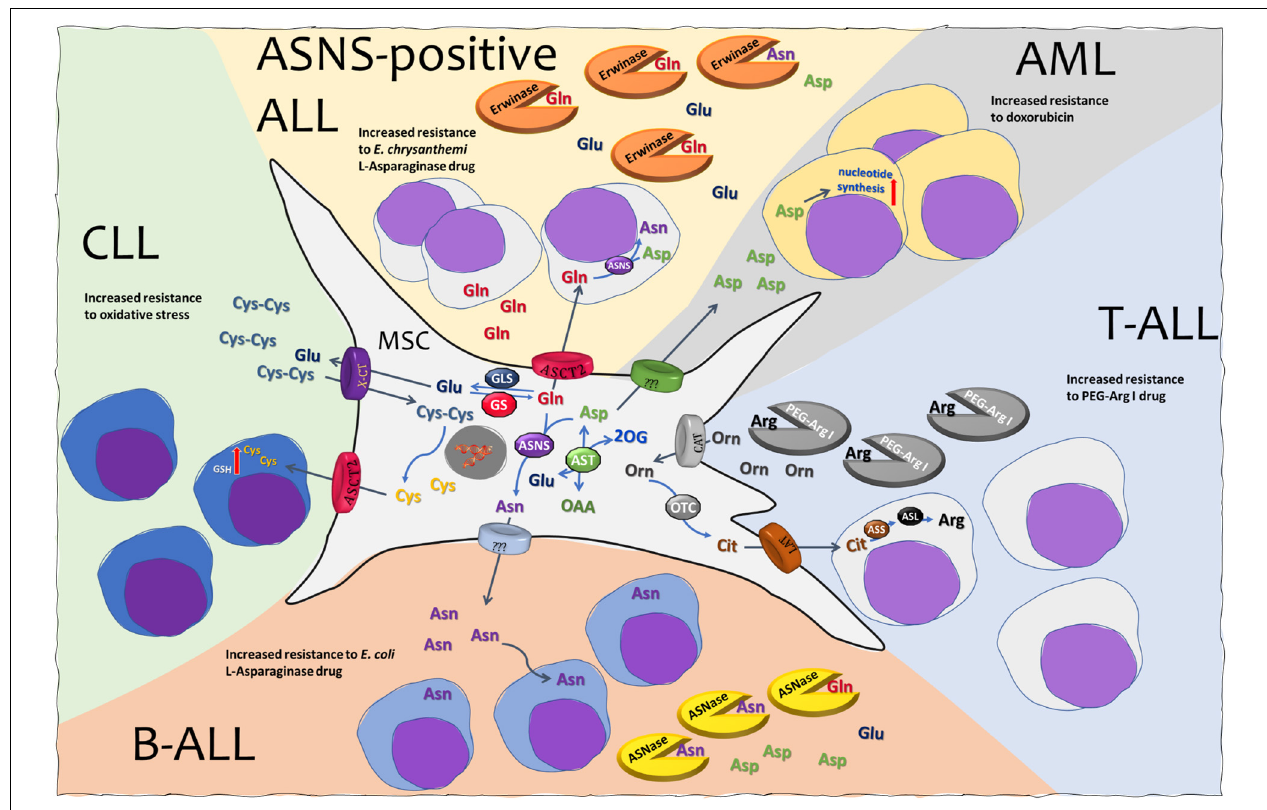
FIGURE 1 | Mesenchymal stromal cells (MSCs) and amino acid crosstalk in leukemia. See text for explanation. MSC, mesenchymal stromal cell; ALL, acute lymphoblastic leukemia; AML, acute myeloid leukemia; CLL, chronic lymphocytic leukemia; ASNS, asparagine synthetase; ASL, argininosuccinate lyase; ASS, argininosuccinate synthetase; AST, aspartate aminotransferase; OTC, ornithine transcarbamylase; GLS, glutaminase; GS, glutamine synthetase; ASNase, l-asparaginase from E. coli . Erwinase, l-asparaginase from E. chrysanthemi ; PEG-Arg I, PEGylated recombinant human arginase I; ASCT2, alanine serine cysteine transporter 2; CAT, cationic amino acid transporter; LAT, large neutral amino acid transporter; X-CT, cystine/glutamate